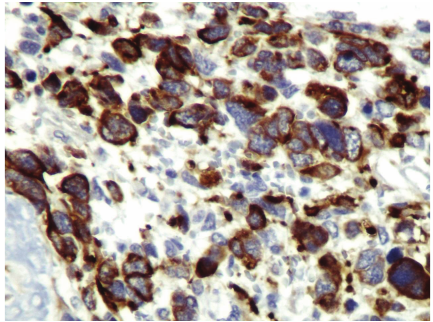
Figure 9: Desmin: cytoplasmic staining: × 400.